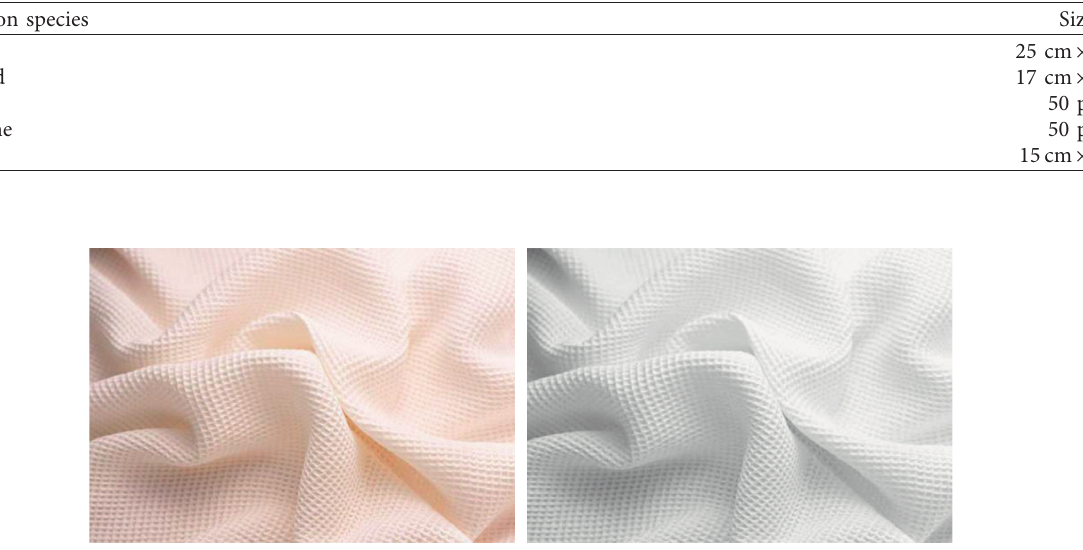
Figure 2: The effect of MATLAB meshing (http://alturl.com/c4dkq). Table 2: Clothing accessories’ specifications.